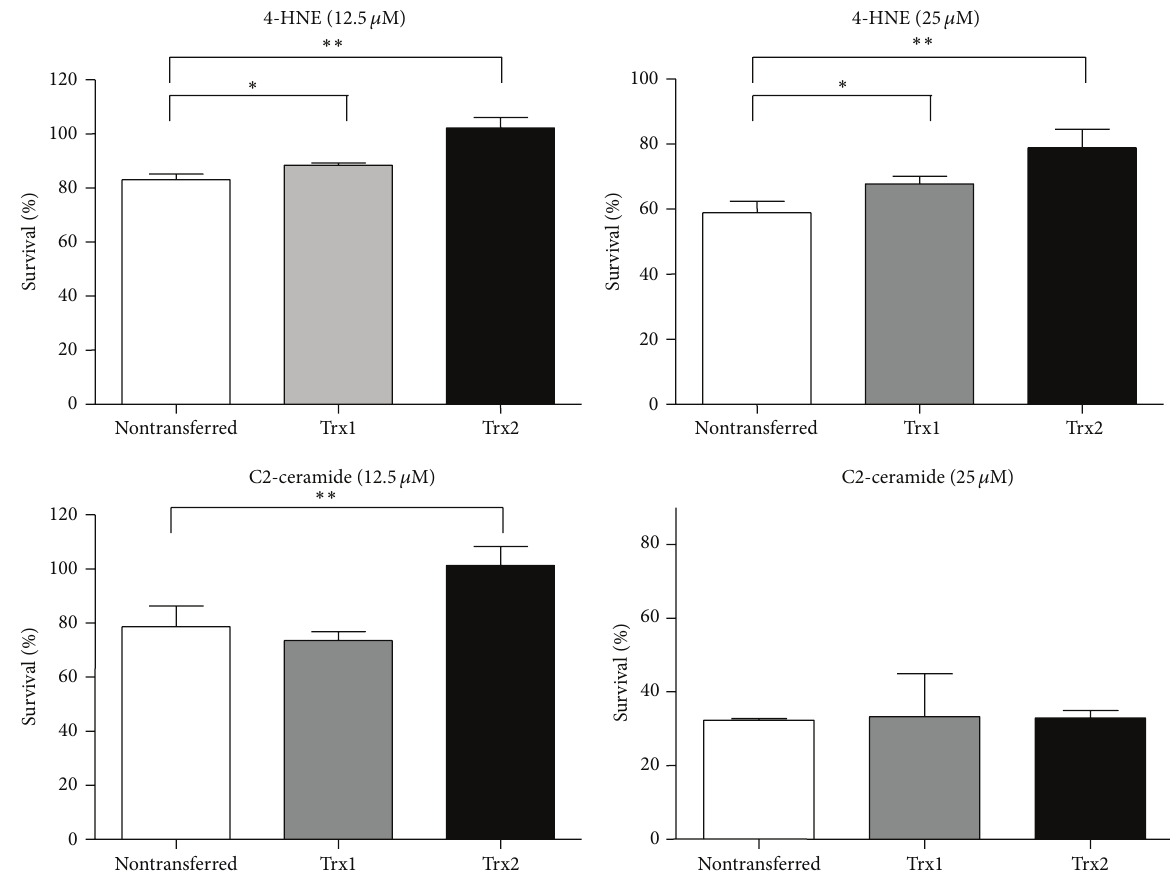
Figure 4: Protective effect of Trx2 against oxidative stress. ARPE-Trx1, ARPE-Trx2, ARPE-pmCherry, and uninfected ARPE cells were exposed to 4-HNE or C2-ceramide. After 24 hours of incubation, cell viability was assessed using the MTS assay. Untreated ARPE cells were also analyzed and their number was defined as 100% survival. Data represent the mean ± SD ( 𝑛 = 5 , ∗ 𝑃 < 0.05 ; ∗∗ 𝑃 < 0.01 ; unpaired t